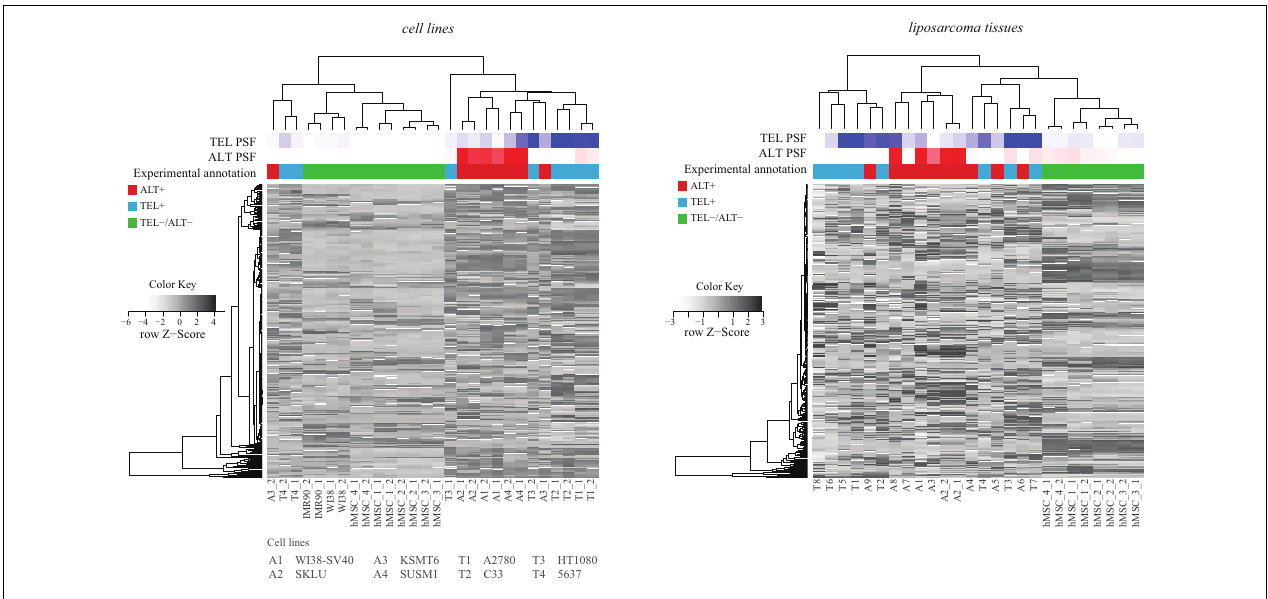
FIGURE 4 | Hierarchical clustering of cell lines and tissues based on expression of genes retrieved from the TelNet database. TEL and ALT PSF values are depicted with blue and red color gradients, and experimental annotations are drawn below. PSF and TelNet assignments closely agree each with